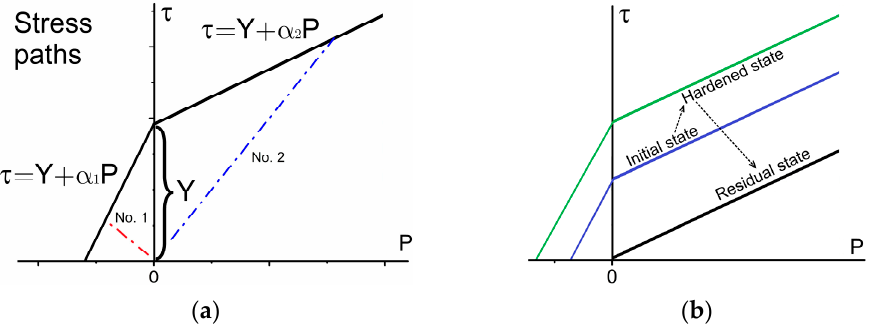
Figure 3. Yield/damage surface and possible stress paths in elastic stage of deformation ( a ), schematic representation of the yield/damage surface evolution ( b ).